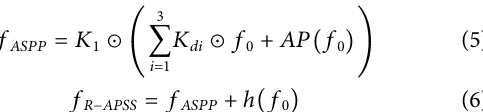
Frontiers in Bioengineering and Biotechnology |